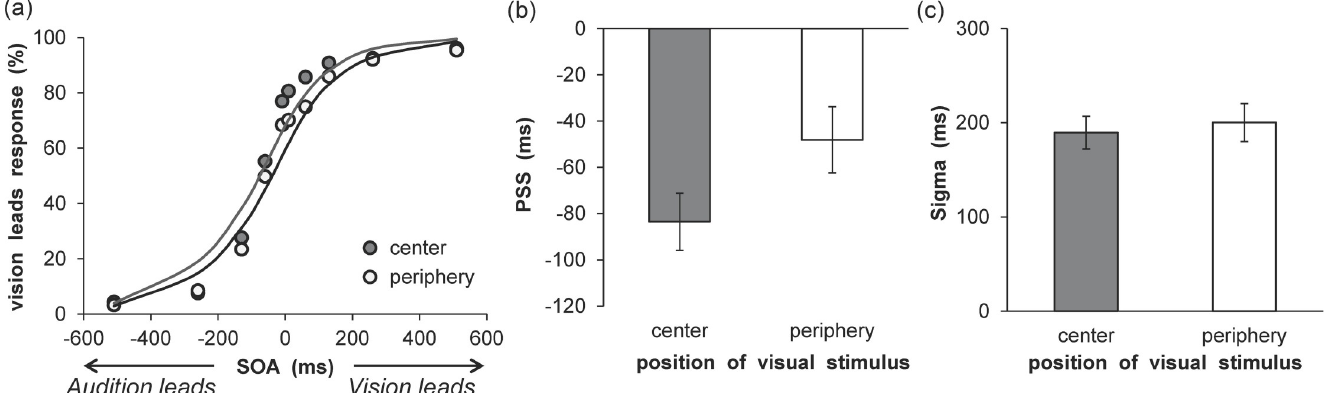
Fig 2. Results of synchrony perception analyses in Experiment 1. (a) Mean percentage of vision lead responses. The average fitting functions are plotted for the central and peripheral visual field data. (b) Mean estimated point of subjective simultaneity. (c) Mean estimated sigma. Error bars represent standard errors of the mean ( n =